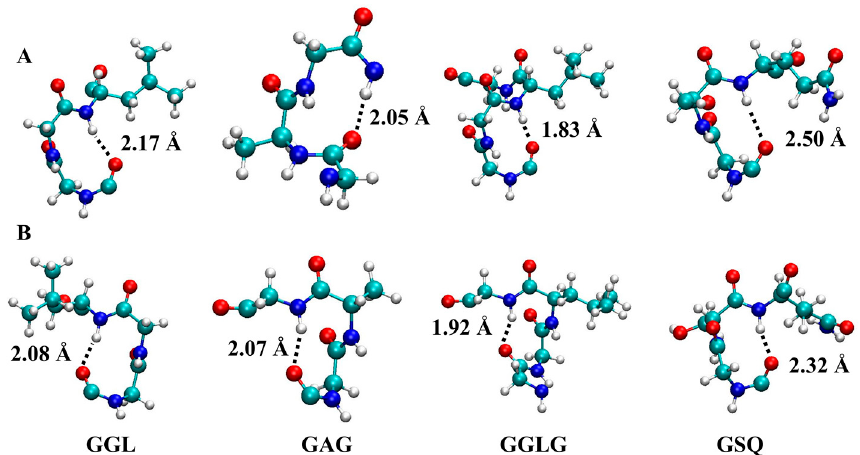
Figure 6. Structure of the most commonly formed 3 10 -helices. Top panels ( A ) show right-handed 3 10 -helices, bottom panels ( B ) show left-handed helices. Hydrogen, oxygen, nitrogen, and carbon are indicated in grey, red, blue and green, respectively. Hydrogen-bond lengths are indicated by dotted lines, and their lengths are given.